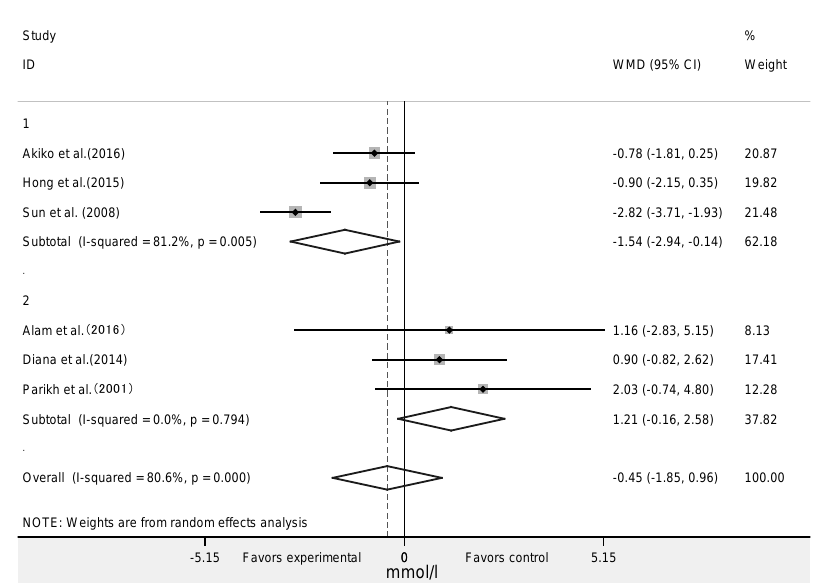
Figure 6. Forest plot of the effect of algae supplementation on 2hPBG in different regions. Table 2. Results of the effect of algae and its extracts supplementation on outcomes based on subgroup analyses.